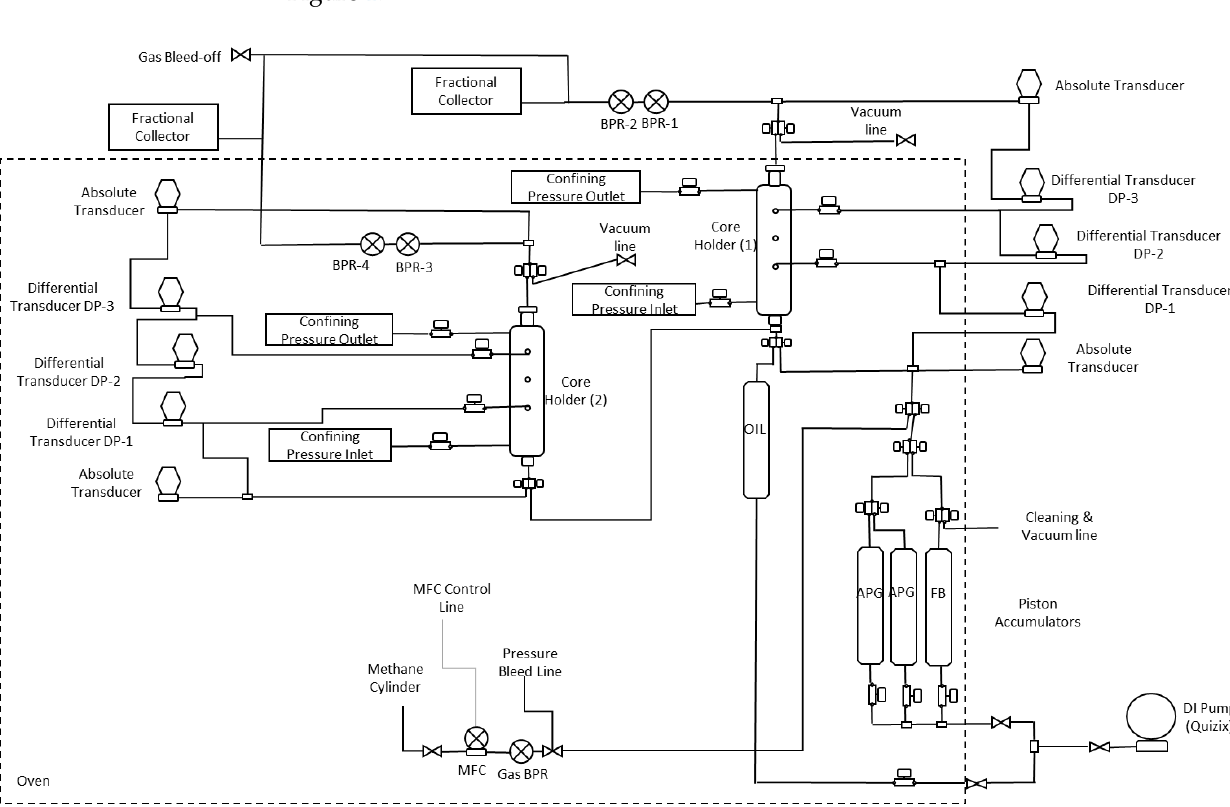
Figure 1. Core Flooding setup configured to single or dual injection core floods.